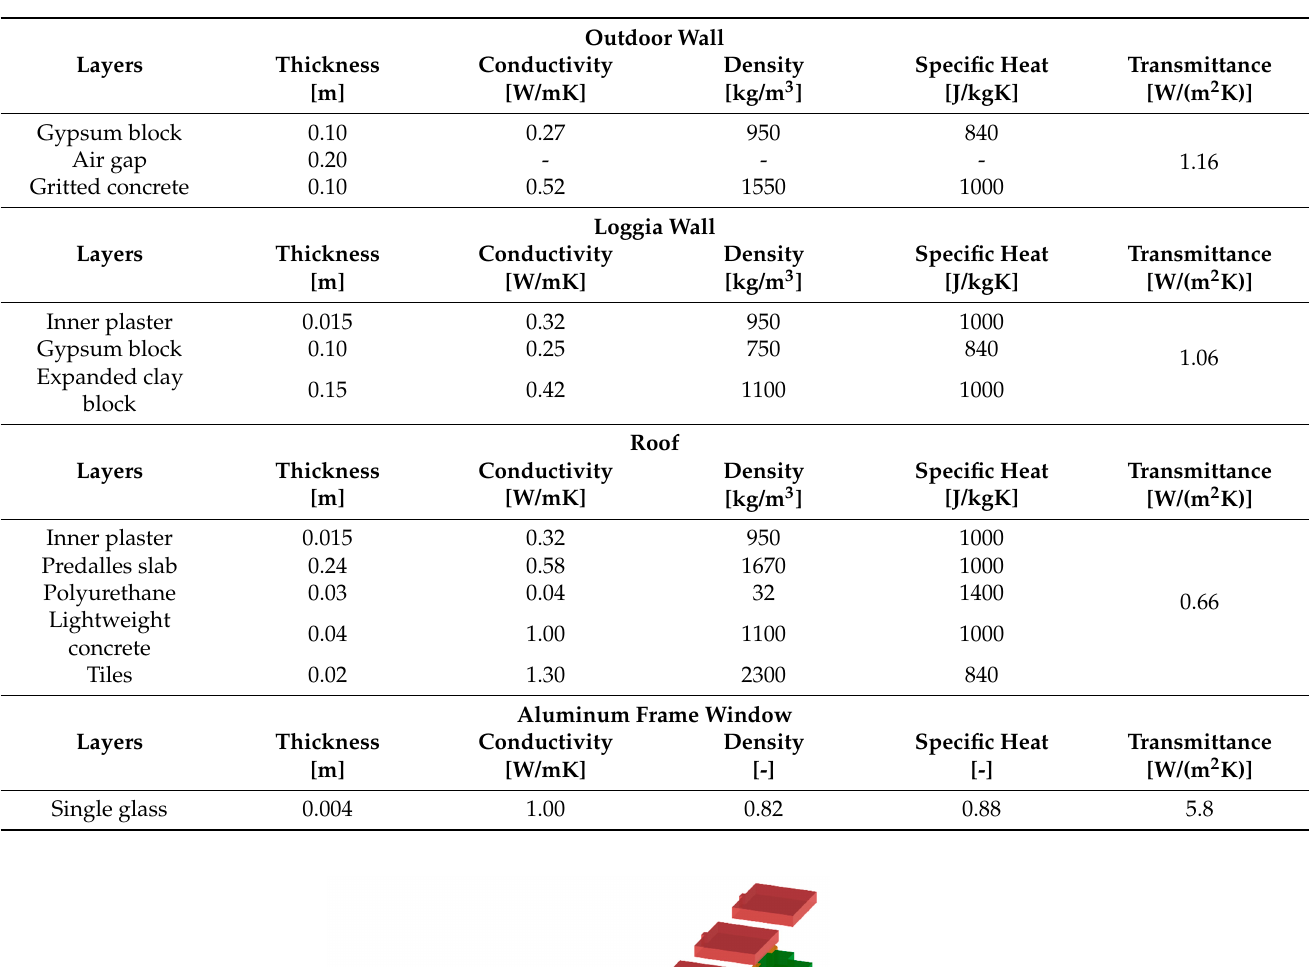
Table 1. Description of layers and thermo-physical features of the envelope from the innermost to the outermost layer.